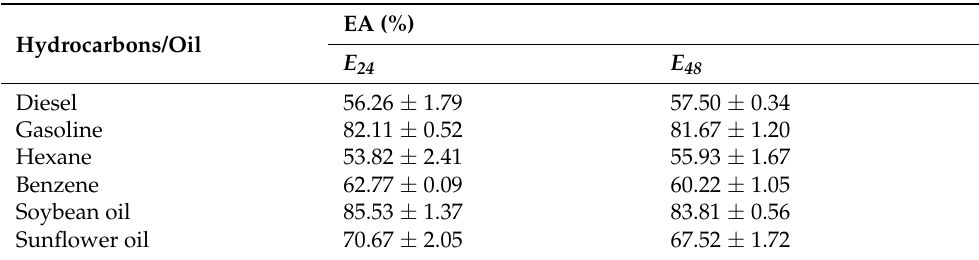
Table 1. Emulsification activity (EA) % of dextran produced by Ln. mesenteroides glucansucrase with hydrocarbons and oils. (E24) 24 h; (E48) 48 h.